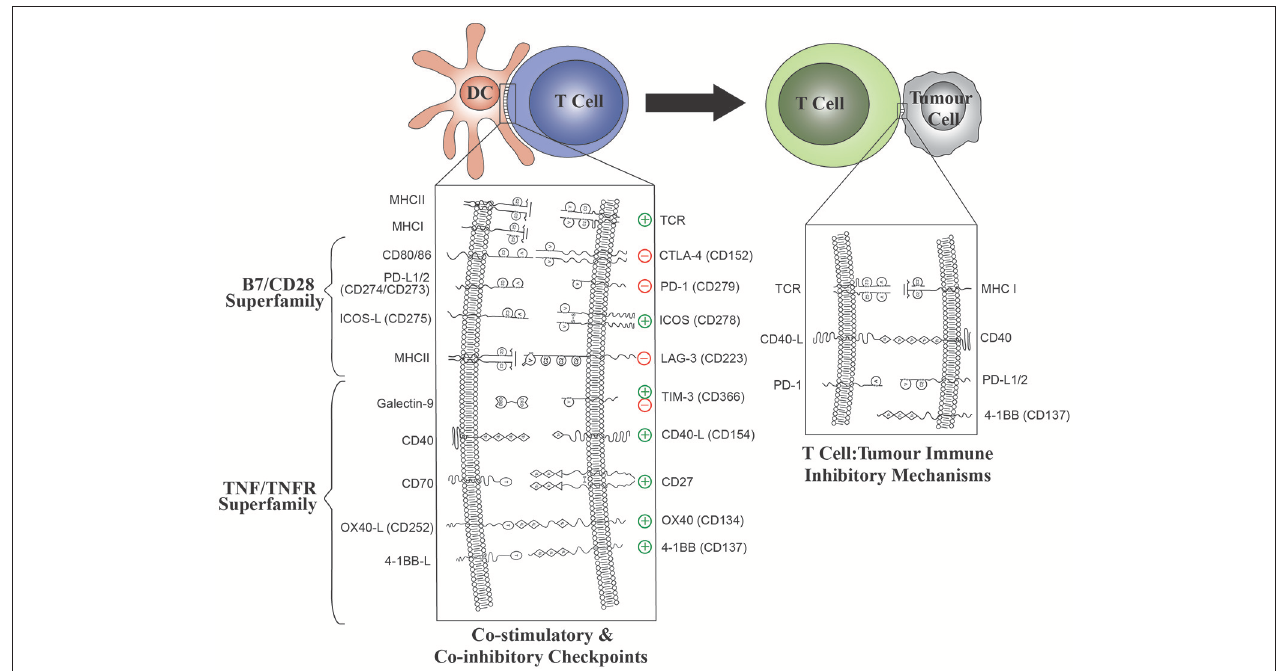
FIGURE 2 | The role of B7/CD28 and TNFR Superfamily co-stimulatory and co-inhibitory molecules in both DC: T-cell and T cell: tumor interactions. Modulation of ligand expression on DC will enable optimal T cell stimulation. The effect of DC ligands on T cell effector functions is shown for each ligand: receptor